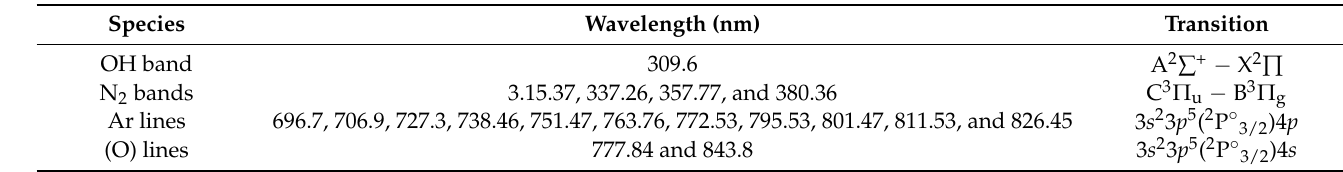
Figure 3. Heat impacting the bacterial colonies as a function of laminar mode flow for dry and wet argon discharge. Table 2. OES data with corresponding species elements, wavelength, and transitions for hydroxide and nitrogen bands, and Argon with oxygen